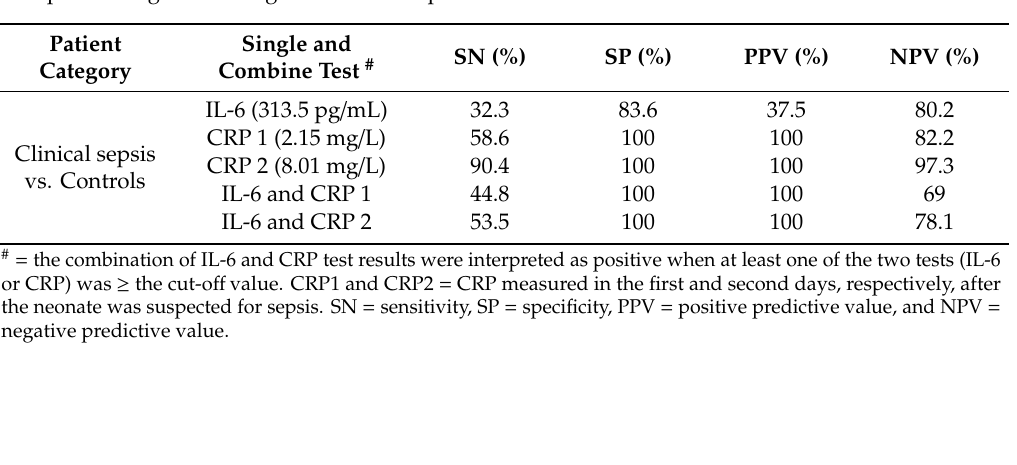
Table 4. The diagnostic performance of IL-6 and CRP at their optimal cut-o ff values for identification of sepsis among culture negative clinical sepsis